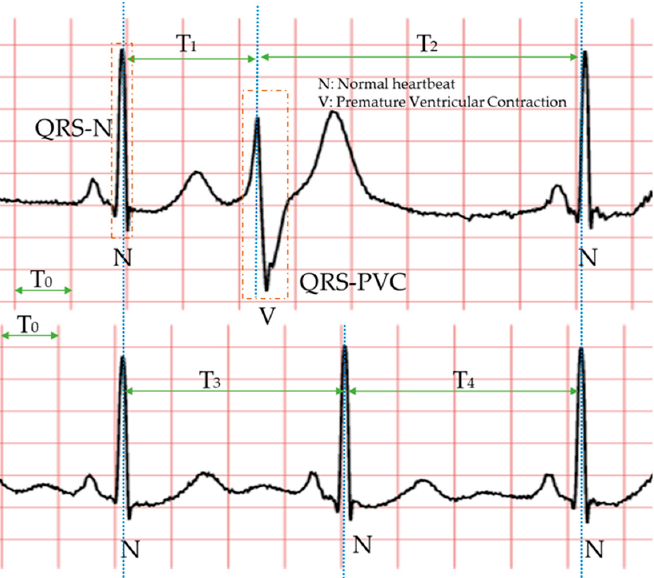
Figure 2. The waveforms of PVC and normal heartbeat. The two ECGs in this picture are from the same person. Each symbol is defined as follows. N (normal heartbeat); V (premature ventricular contraction); T 0 (0.20 s); T 1 (R-R interval); T 2 (R-R interval); T 3 (R-R interval); T 4 (R-R interval); QRS-N (QRS complex of normal heartbeat); QRS-V (QRS complex of PVC). The important thing is that T 3 and T 4 are usually equal, and the sum of them is generally similar to the sum of T 1 and T 2 . The blue dotted line indicates the location of the R wave peak in each heartbeat.